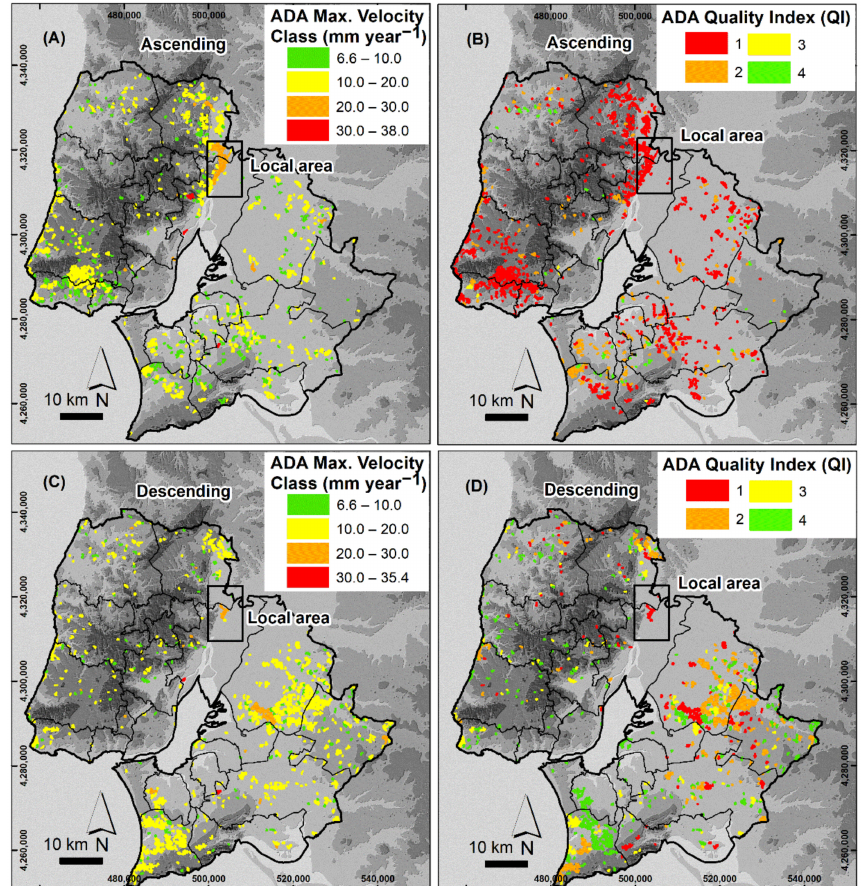
Figure 4. ADA extracted in the LMA at regional scale. ( A ) Maximum velocity class (mm year − 1 ) of ADA from ascending dataset; ( B ) ADA quality index (QI) in ascending trajectory; ( C ) maximum velocity class (mm year − 1 ) of ADA from descending dataset; ( D ) ADA quality index (QI) in descend- ing trajectory. Black rectangles represent the local area analyzed and presented in sub-Section 3.3.2. A-DInSAR Results and